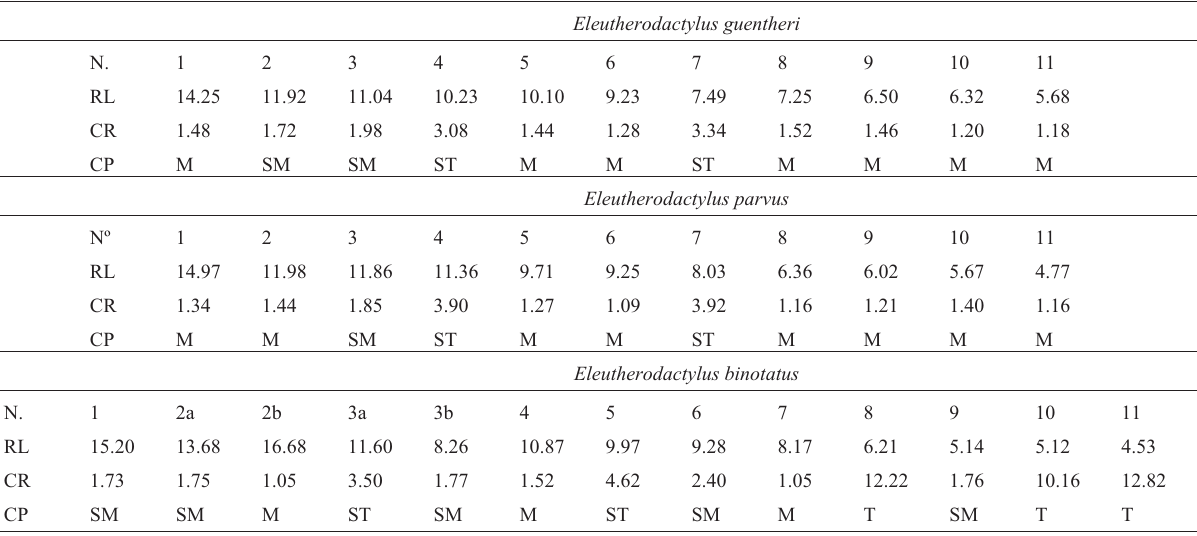
Table 1 - Morphometric data for mitoic chromosomes of Eleutherodactylus guentheri, E. parvus and E. binotatus. In E. binotatus, the letters a and b indicate the different morphs of chromosomes 2 and 3 found in five specimens.